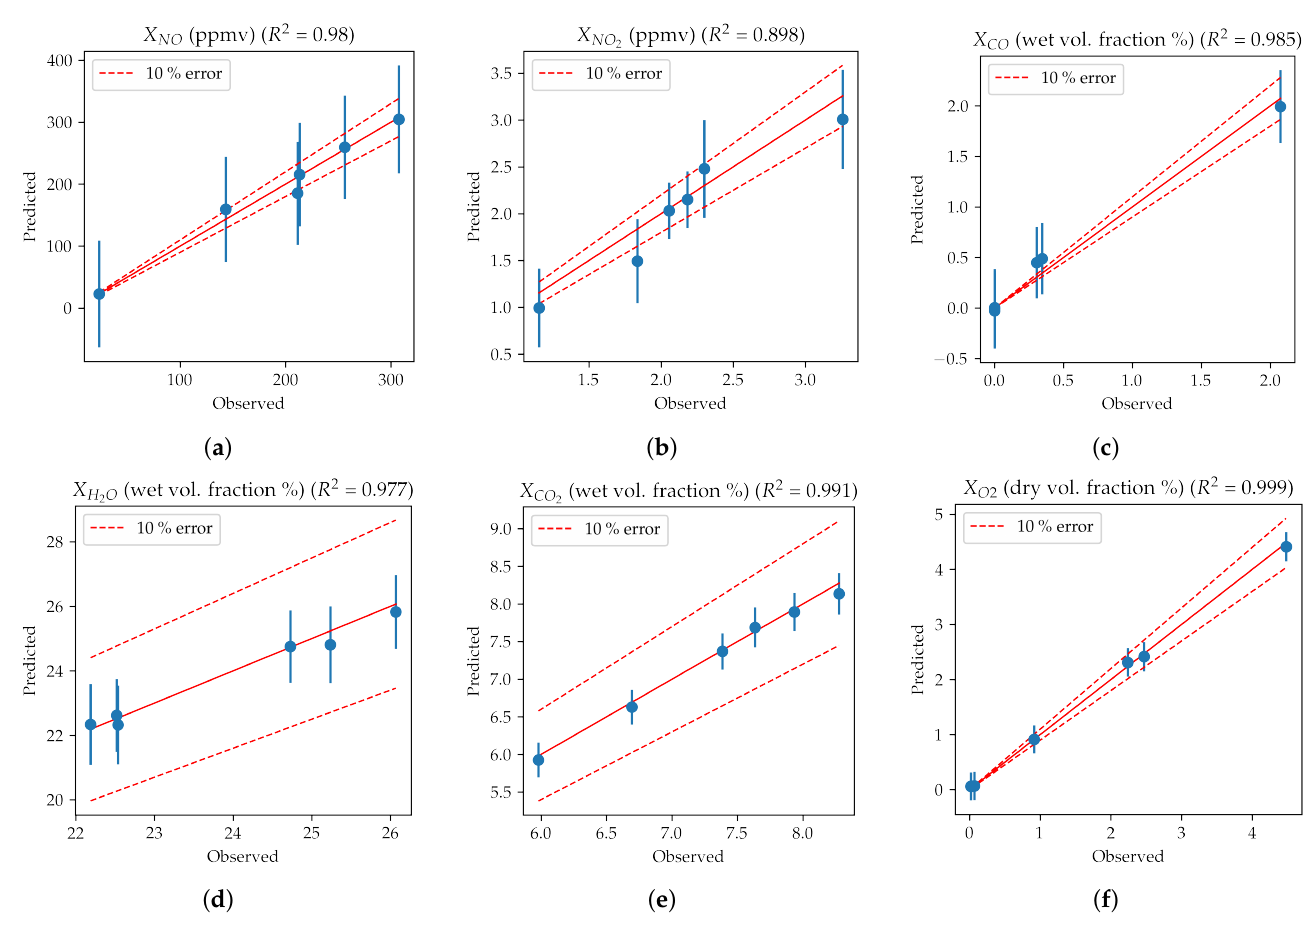
Figure 7. Parity plot for the emissions of NO ( a ); NO 2 ( b ); CO ( c ); H 2 O ( d ); CO 2 ( e ); and O 2 ( f ) for the six testing cases. The uncertainty represents the model’s uncertainty in the